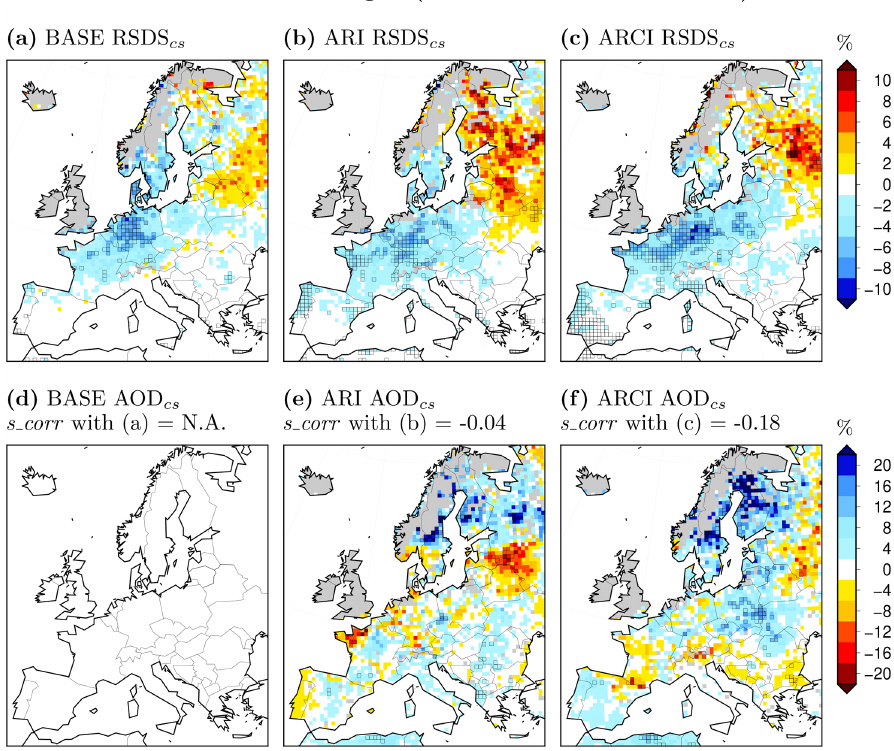
Figure 8. Projected changes for the RSDS cs (a–c) and AOD cs (at 550nm) (d–f) summer (JJA) climatologies; this is under clear-sky condi- tions for the WRF experiments and squared if statistically significant ( p < 0.05; units: percent). The gray shaded areas depict grid points for which less than 75% of the summer mean values in the time series of RSDS cs and AOD cs were not missing in either the historical or the future period. Spatial correlations ( s_corr ) between the patterns in the second row and the respective patterns in the first row are indicated in the